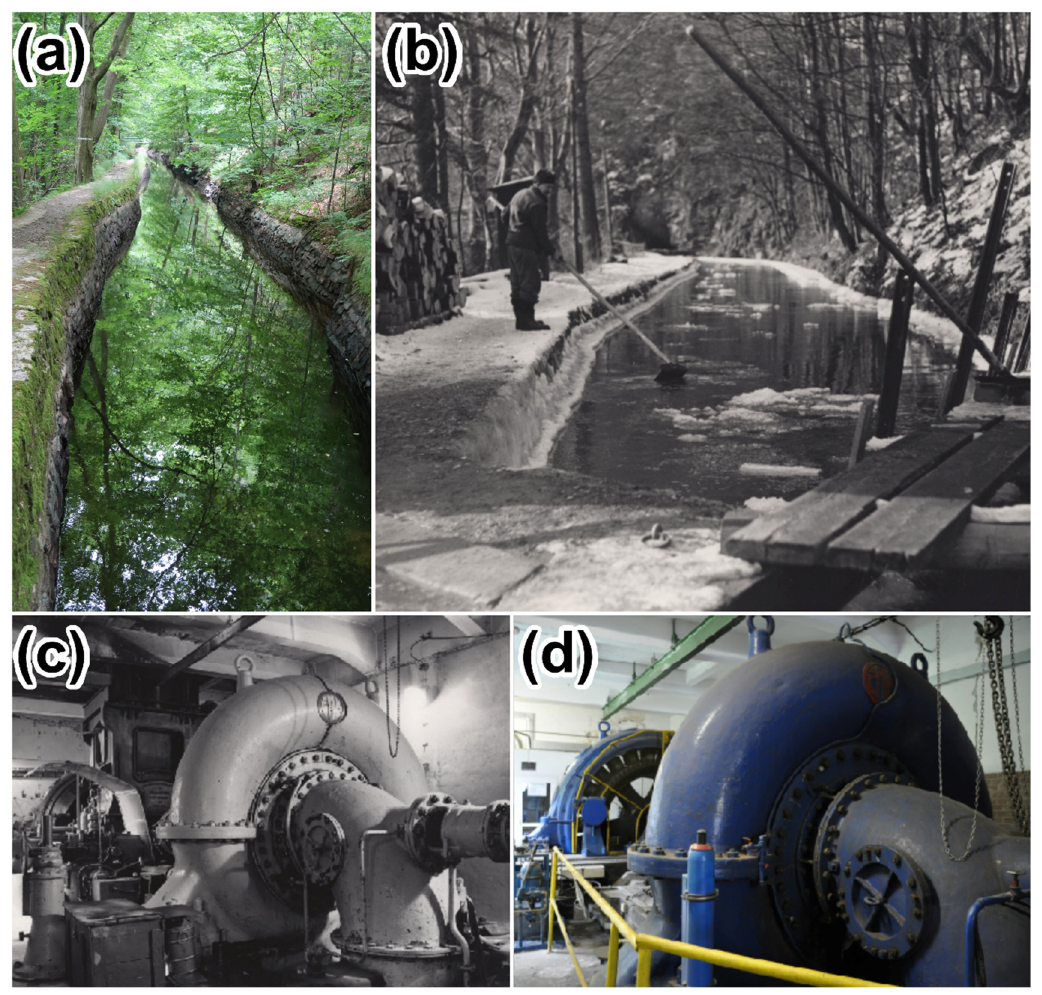
Figure 7. The raceway and the Francis turbine in the hydropower plant of the Žimrovice paper factory: ( a ) the raceway trough, ( b ) a historical photo—ice removal during winter, ( c ) the Francis turbine with a generator—a historical photo, and ( d ) as of 2019 (source: State District Archives in Opava, collection of documentary material).